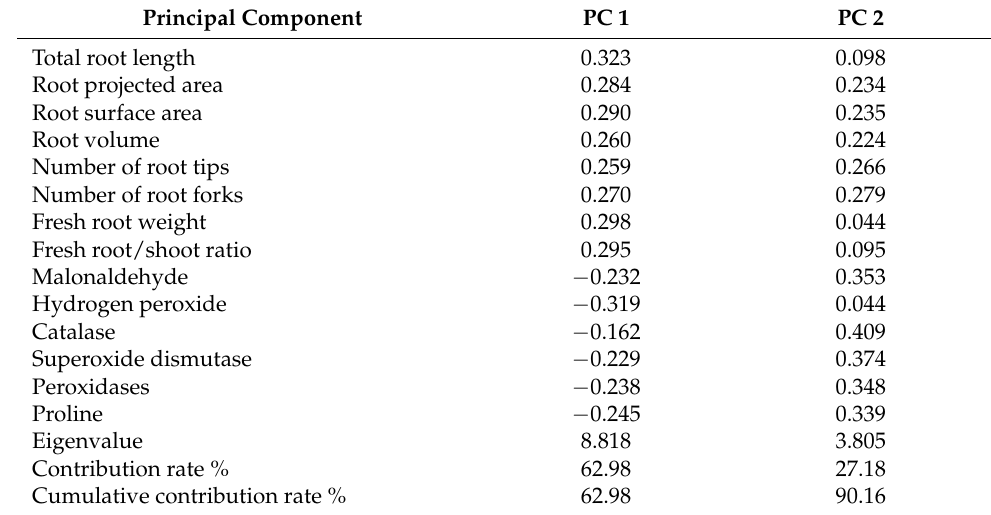
Table 3. Principal Component, loadings related to Phi treatments variable and explained variance for final